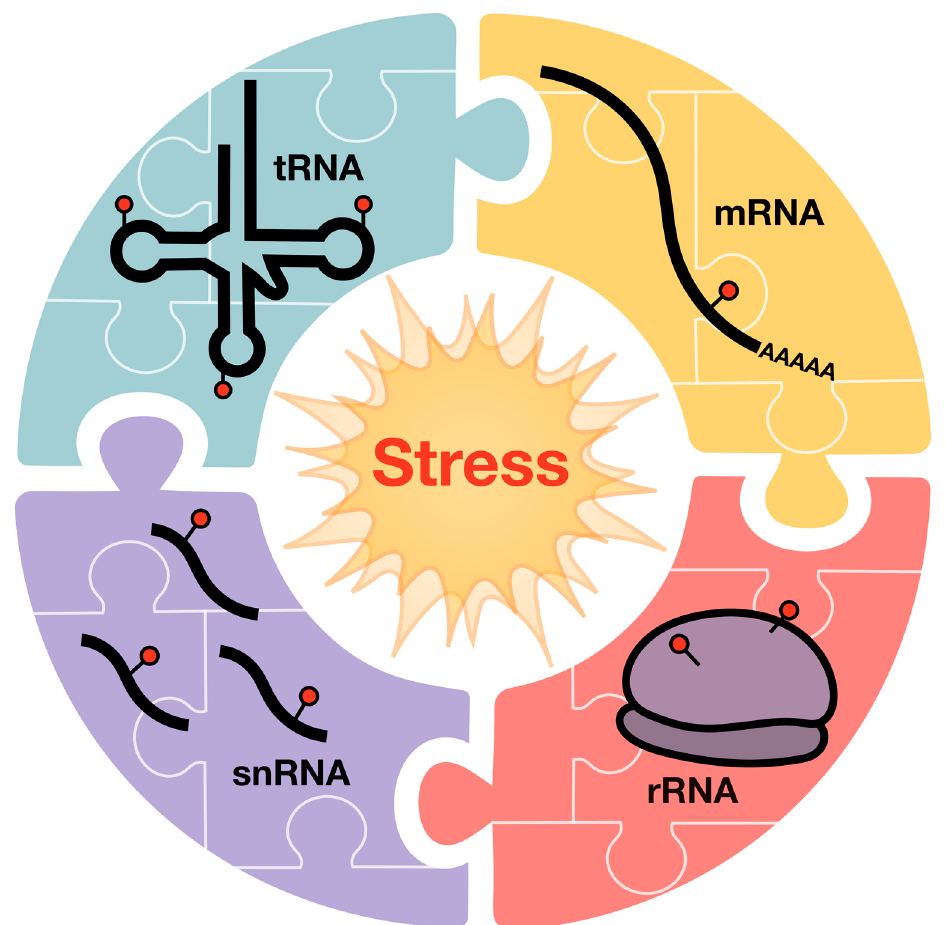
Figure 4. Coordinated changes in epitranscriptomic marks on tRNA, mRNA, rRNA, and snRNA are theorized to drive the translational response to stress, and other physiological responses.